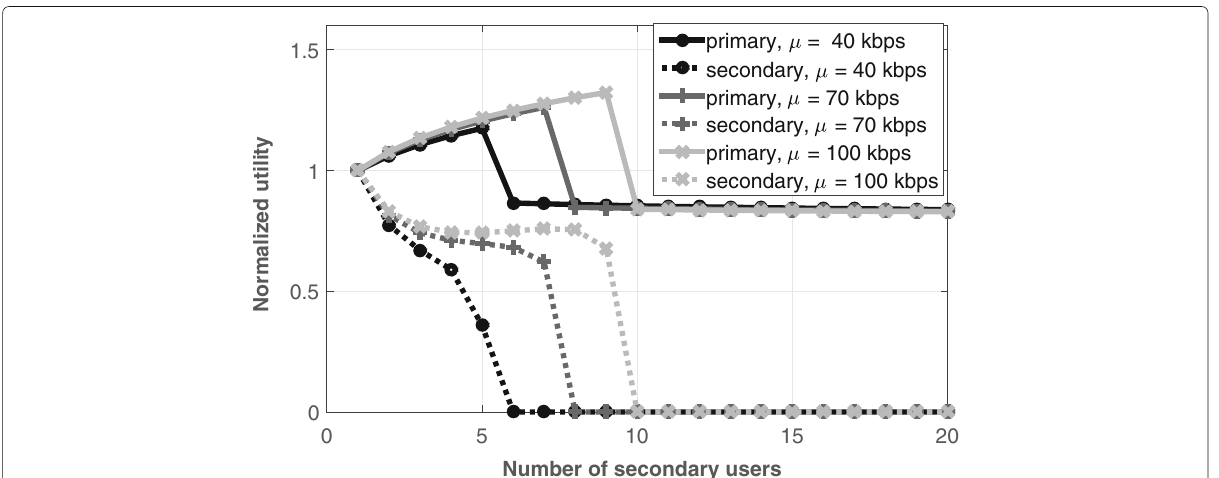
Fig. 5 The two players’ normalized utilities versus the number of secondary users with n p = 1, λ p = 10 kbps, λ s = 1 kbps and different μ ranging from 40 to 100 kbps for the Stackelberg games in Section 3.2 and cost function defined with Eq. 11